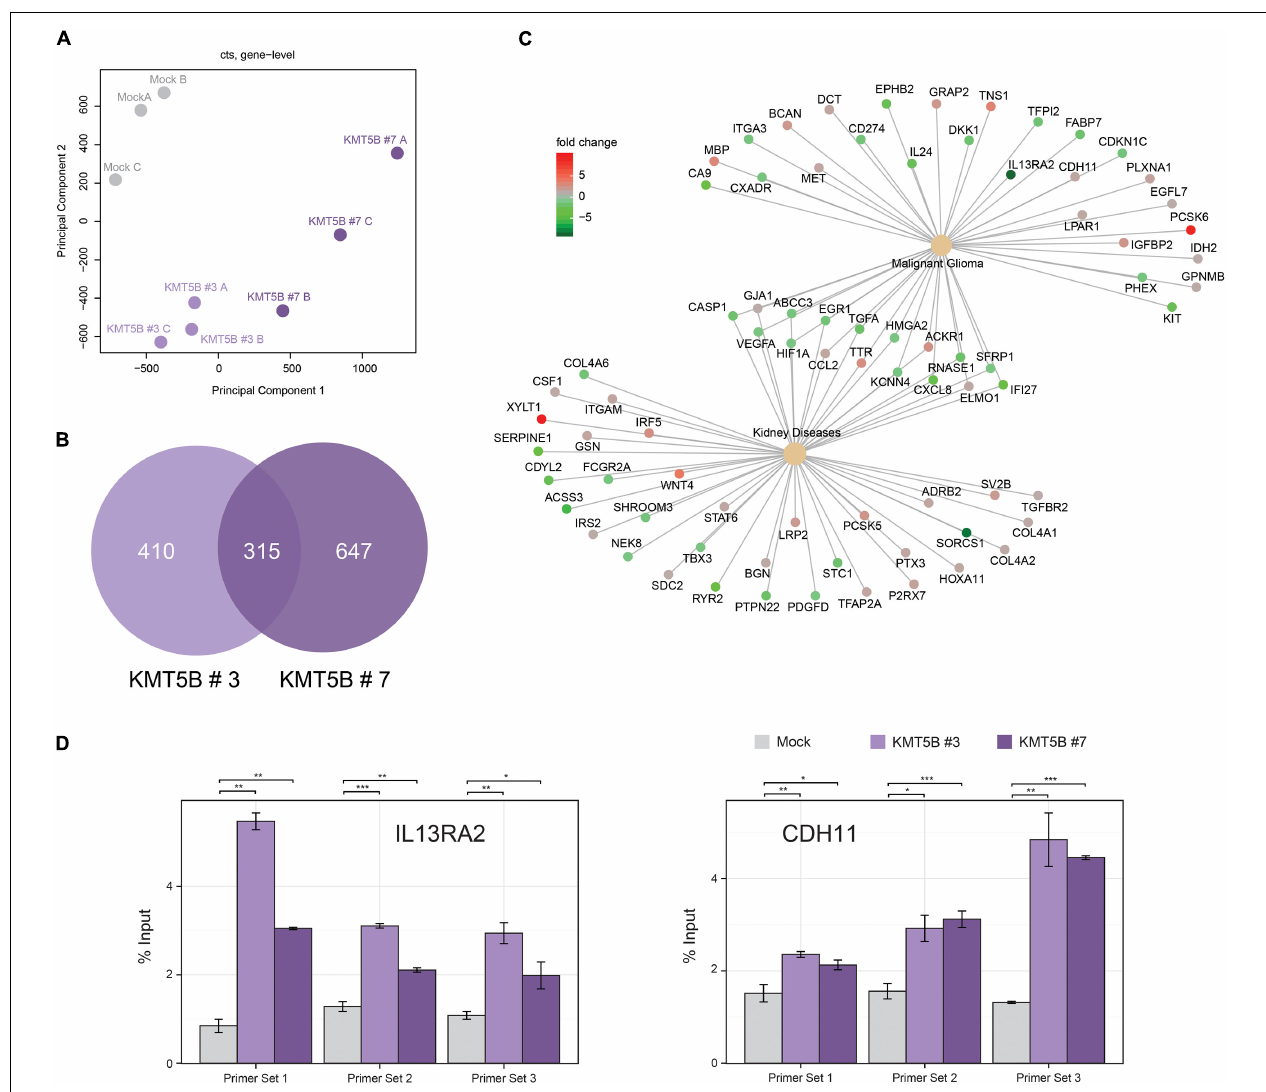
FIGURE 6 | Overexpression of KMT5B alters the expression of several genes, including IL13RA2. (A) Principal component analysis of the three replicates of each clone subjected to RNAseq (B) Venn diagram showing differentially expressed genes in KMT5B -expressing clones KMT5B #3 and KMT5B #7. Both comparisons were made independently against the expression profile of the LN-229 control cells (mock). (C) Network diagram showing the functional relationships between the genes differentially expressed in the RNAseq analysis and disease ontologies (glioblastoma and renal diseases) obtained from DisGeNET. To facilitate the interpretation of the data, the relationships of genes and ontologies common to both conditions are indicated. Information on the expression levels of the different genes compared to the control (mock) is indicated by the colour scale. (D) Enrichment of H4K20me2 upstream of the IL13RA2 and CDH11 transcription start sites due to KMT5B overxpression. Chromatin immunoprecipitation (ChIP) assays were performed in mock and KMT5B stably-transfected LN-229 cells using either anti-H4K20me2 polyclonal antibody or control IgG (see Supplementary Table 2 ). DNA eluted from the ChIP assay was amplified by qRT-PCR with primer sets mapping to IL13RA2 or CDH11 promoters (listed in Supplementary Table 1 ). The enrichment of H4K20me2 at the indicated regions in KMT5B clones was compared to the same regions in mock control cells (Welch t -tests; * p < 0.05; ** p < 0.01; *** p <